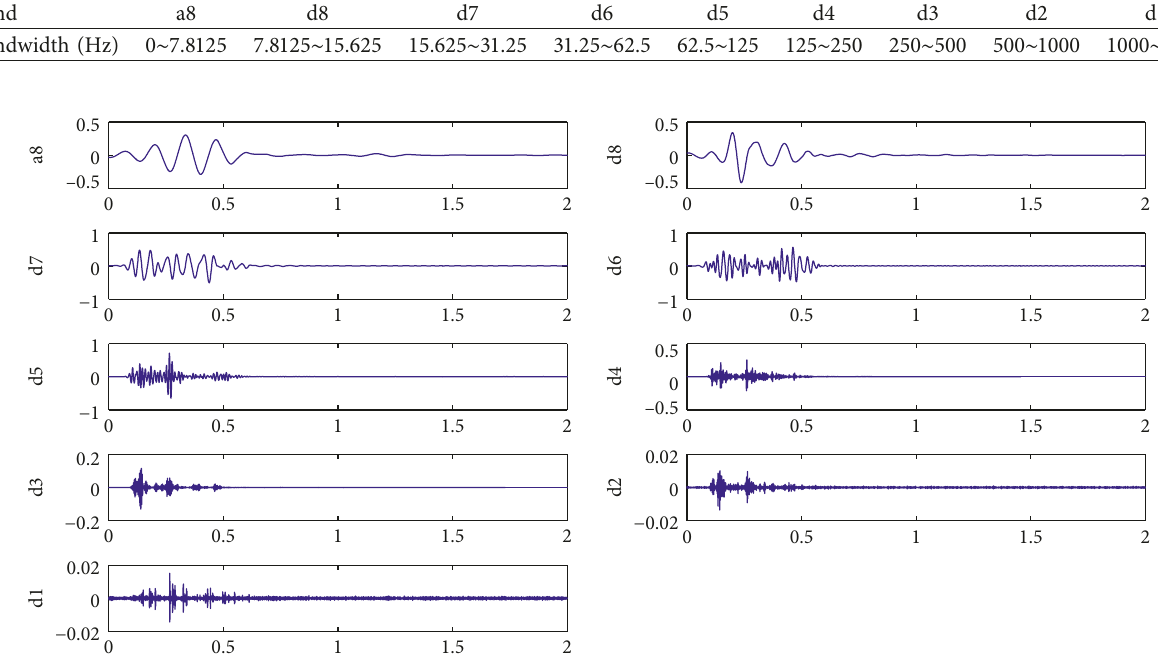
Figure 4: Reconstructed signal of each band in vertical